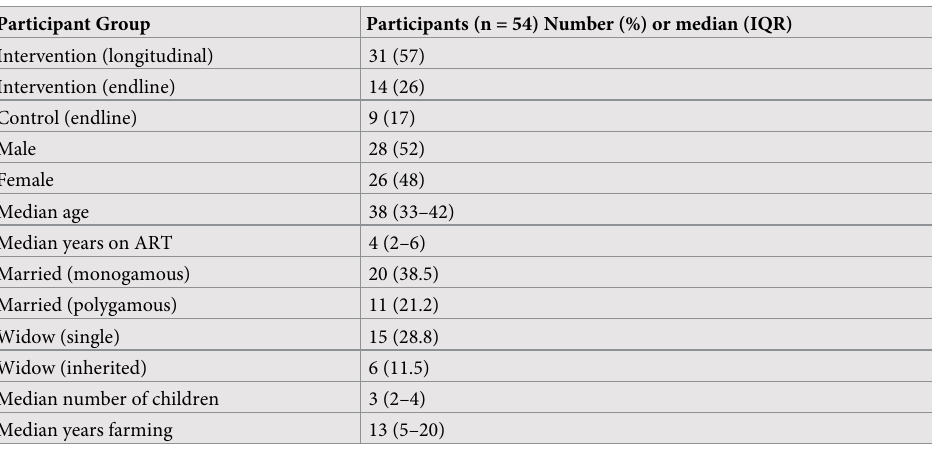
Table 1. Participant